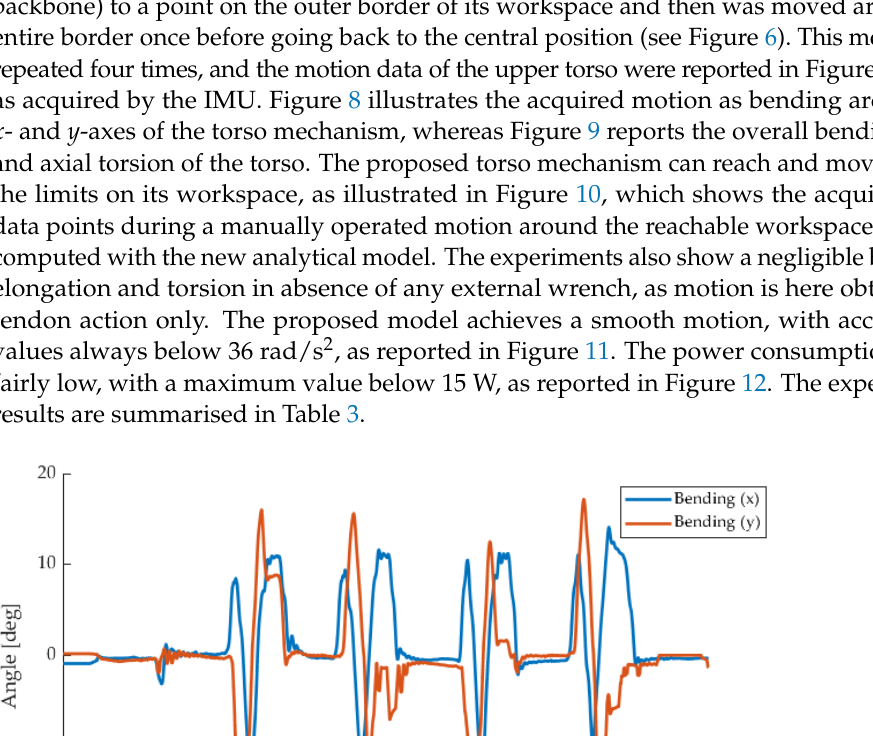
Figure 8. Raw orientation data acquired by the IMU on the upper torso expressed as bending around the x - and y -axes of the upper torso of the robot in Figure 6. Figure 9. Orientation data acquired by the IMU on the upper torso and mapped as torso bending angle 𝜃 and axial torsion ∆𝜑 .